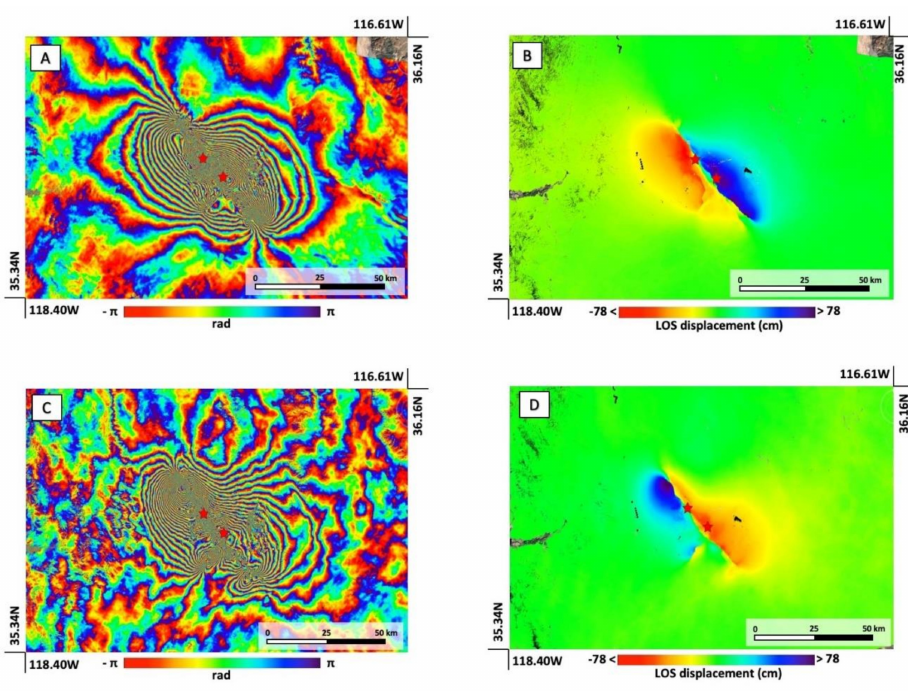
Figure 4. Sentinel-1 results relevant to the Ridgecrest CA seismic events that occurred on 4 and 6 July 2019. ( A ) Coseismic interferogram produced from Sentinel-1 (S1) descending images (Track 61) spanning the time interval 4 July 2019–16 July 2019. ( B ) Coseismic displacement map related to the interferogram reported in ( A ). ( C ) Coseismic interferogram produced from S1 ascending images (Track 71) spanning the time interval 4 July 2019–10 July 2019. ( D ) Coseismic displacement map related to the interferogram reported in (C). The red stars identify the epicenters for the two (4 and 6 July 2019) seismic